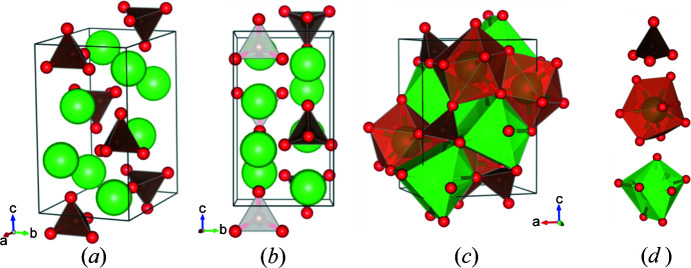
(a) Crystal structure of the Sr2CO4 orthocarbonate at 92 GPa. (b) Viewed along the a axis, when the atoms lying on the a
c mirror plane (b =  and ) are clearly visible. (c) Polyhedral representation of Sr2CO4. (d) The three building blocks of Sr2CO4, namely: CO4, SrO11 and SrO9 (top to bottom).